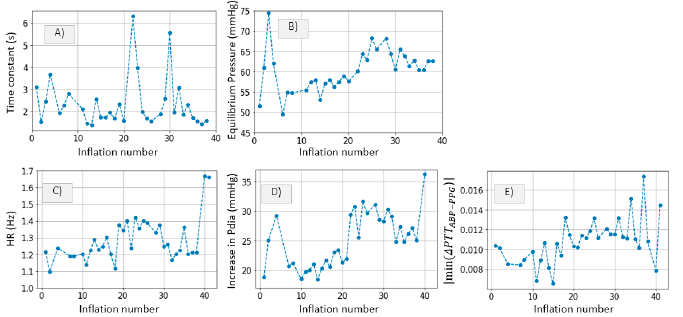
Figure 18. ( A ) Time constant τ and ( B ) P Equilibrium from Patient 1 data. ( C ) HR, ( D ) increase in P dia and ( E ) maximum drop in ∆ PTT ABP − PPG are plotted for qualitative